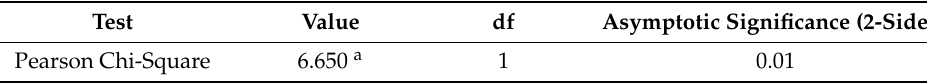
Table 7. Hypothesis 4 Chi-Square